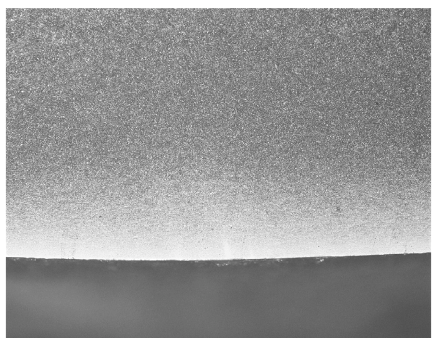
Figure 13: Micromorphology of carbon inclusions near the fracture surface depletion near the fracture origin.